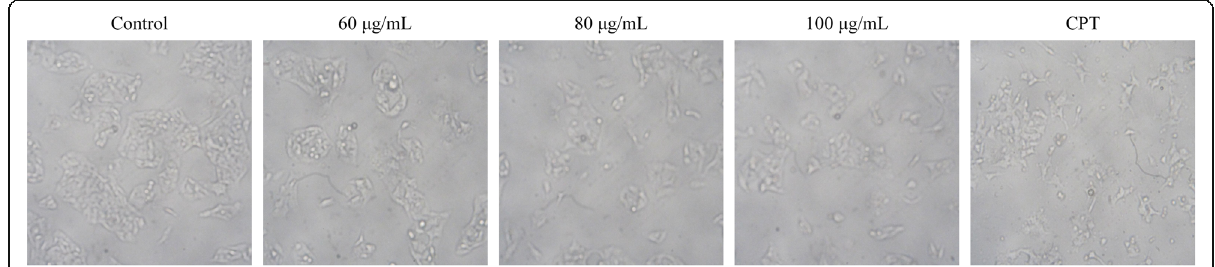
Fig. 2 Morphological transforms were observed in HepG2 cancer cells. Cells were treated without (Control) or with different concentrations of AP-XS extract and Camptothecin (CPT) for 60 h